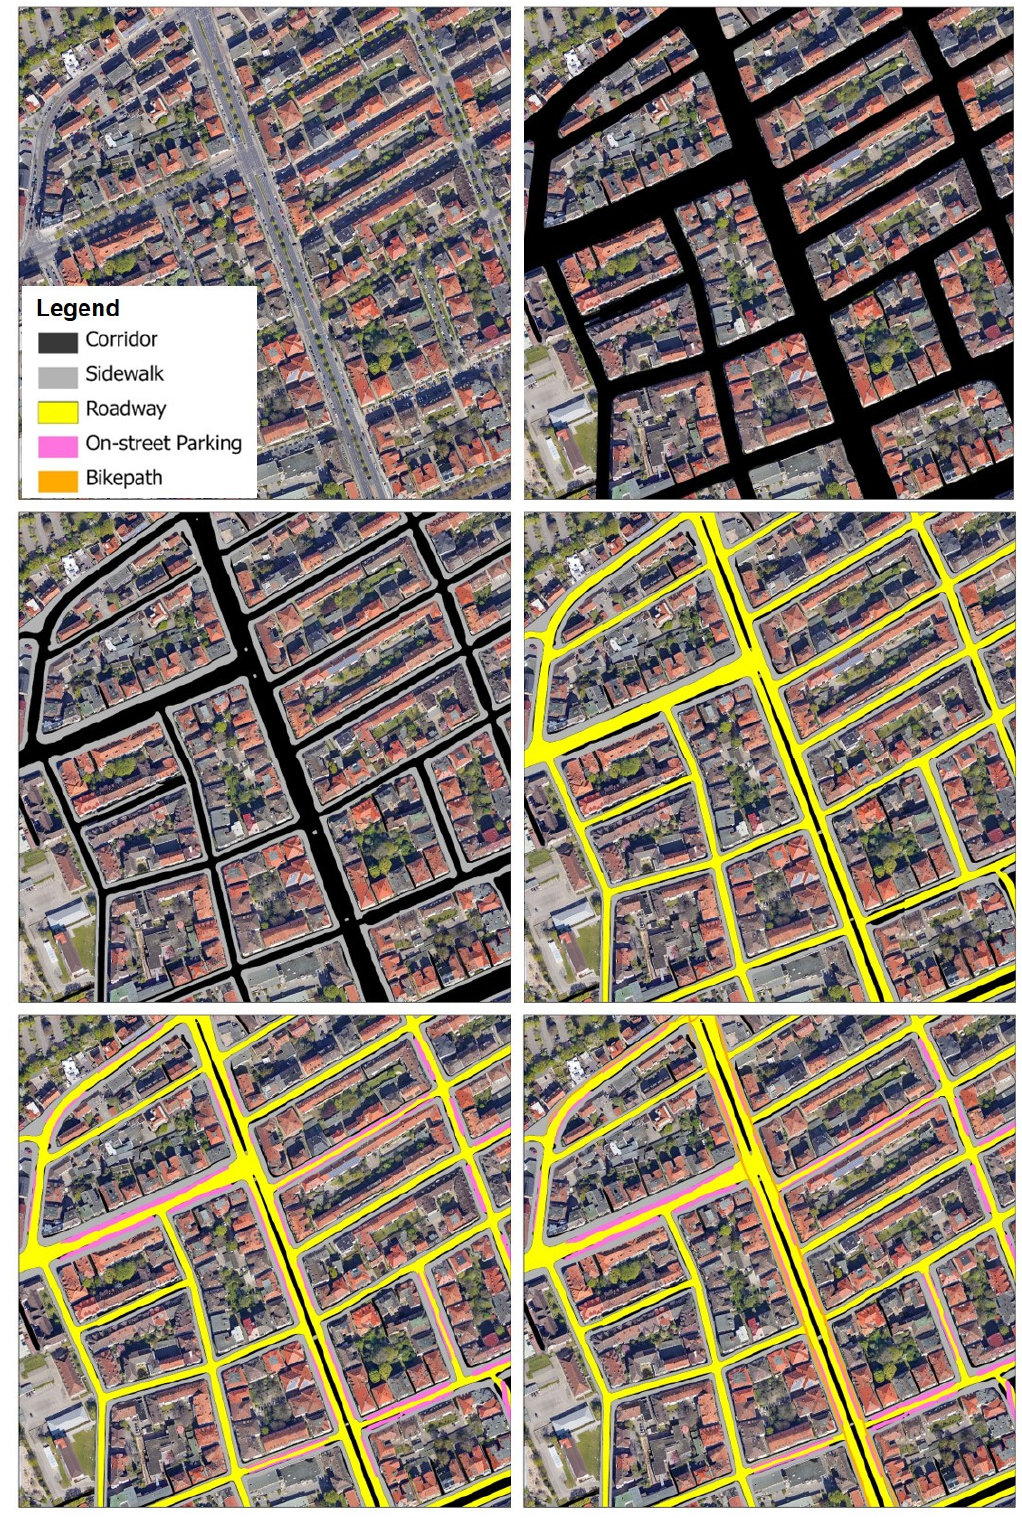
Figure 5. Tiles showing output from the D-LinkNet34 segmentation model in the study area.